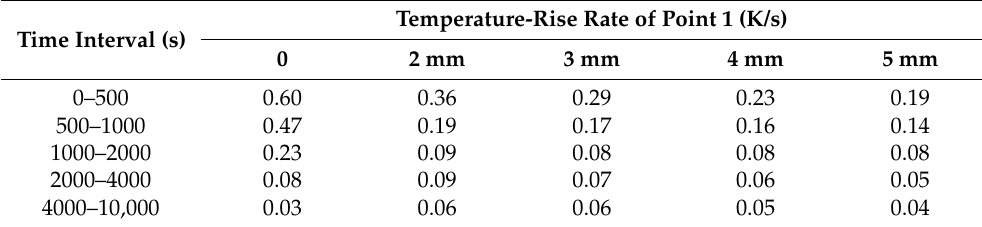
Table 7. Temperature-rise rate with different initial thicknesses at different